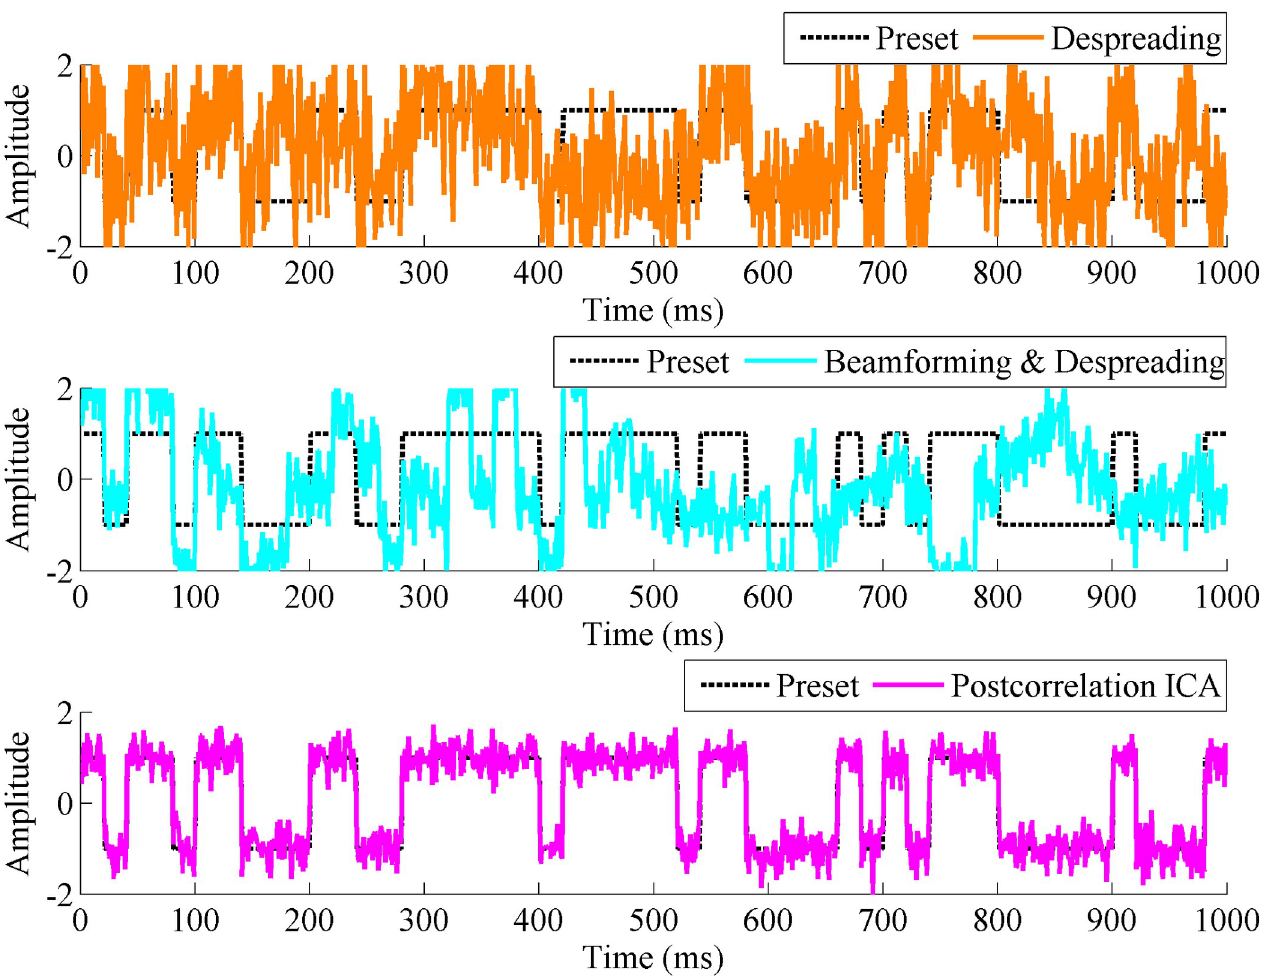
Fig 4. Comparison of the navigation message after despreading, beamforming and despreading, and postcorrelation ICA algorithm processing.